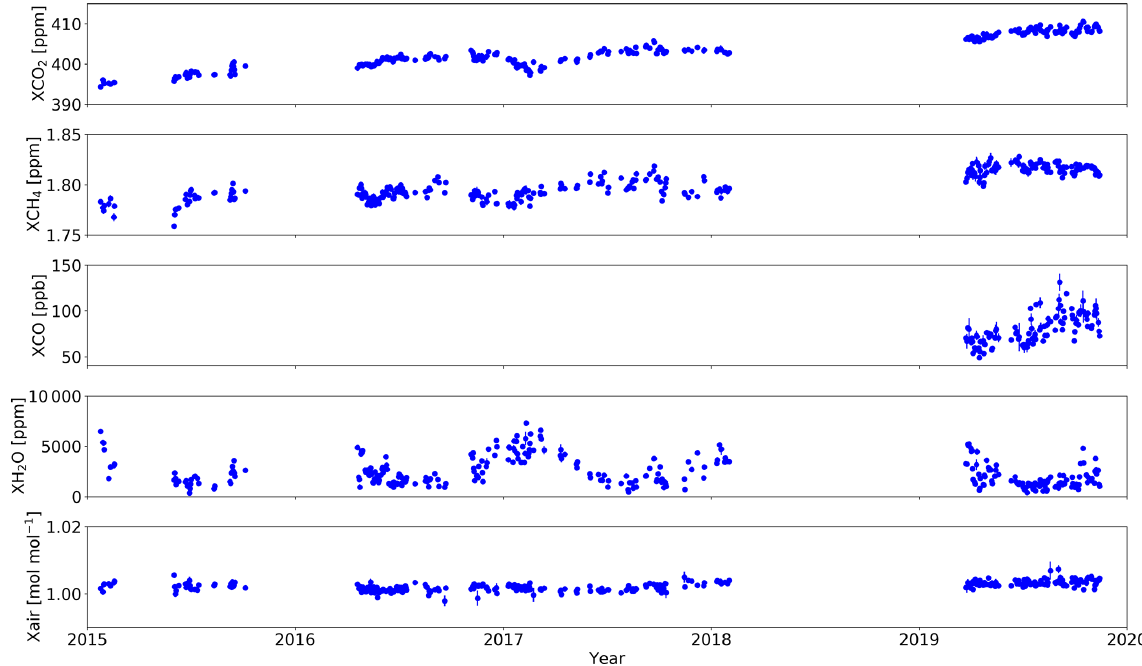
Figure 5. Column-averaged dry-air mole fraction time series for XCO 2 , XCH 4 , XCO, XH 2 O and X air measured at the COCCON site in Gobabeb, Namibia, from January 2015 until November 2019. Daily mean values are shown for better visibility. Error bars denote the 1 σ standard deviation of the daily mean values. In 2018, the instrument was upgraded with a second channel. Therefore, XCO observations only started in 2019.